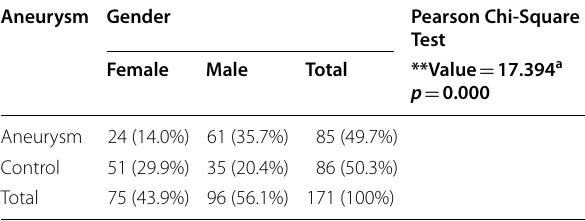
**Difference is significant at the 0.01 level (2-tailed) a Positive relation between Man gender and Aneurysm ( p <